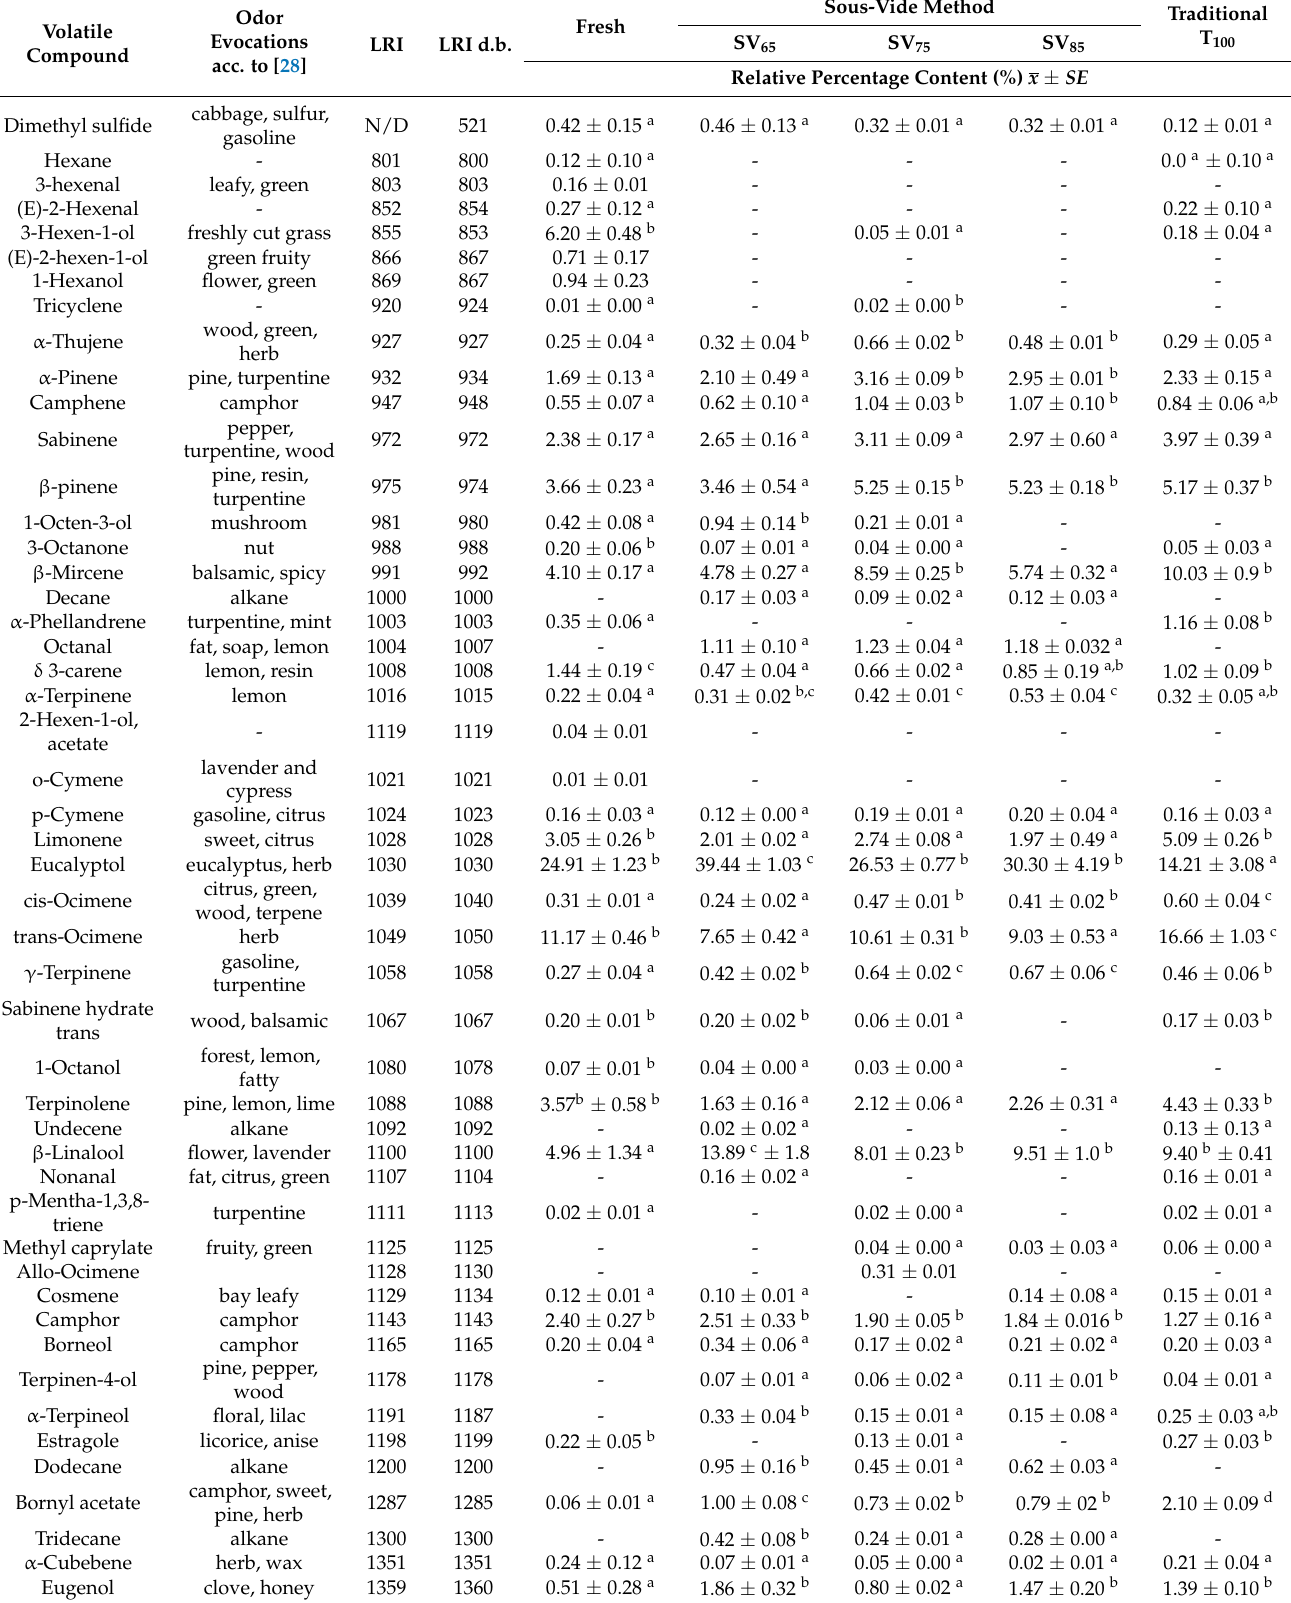
Table 1. Effect of various heat treatment methods on the volatile profile of basil